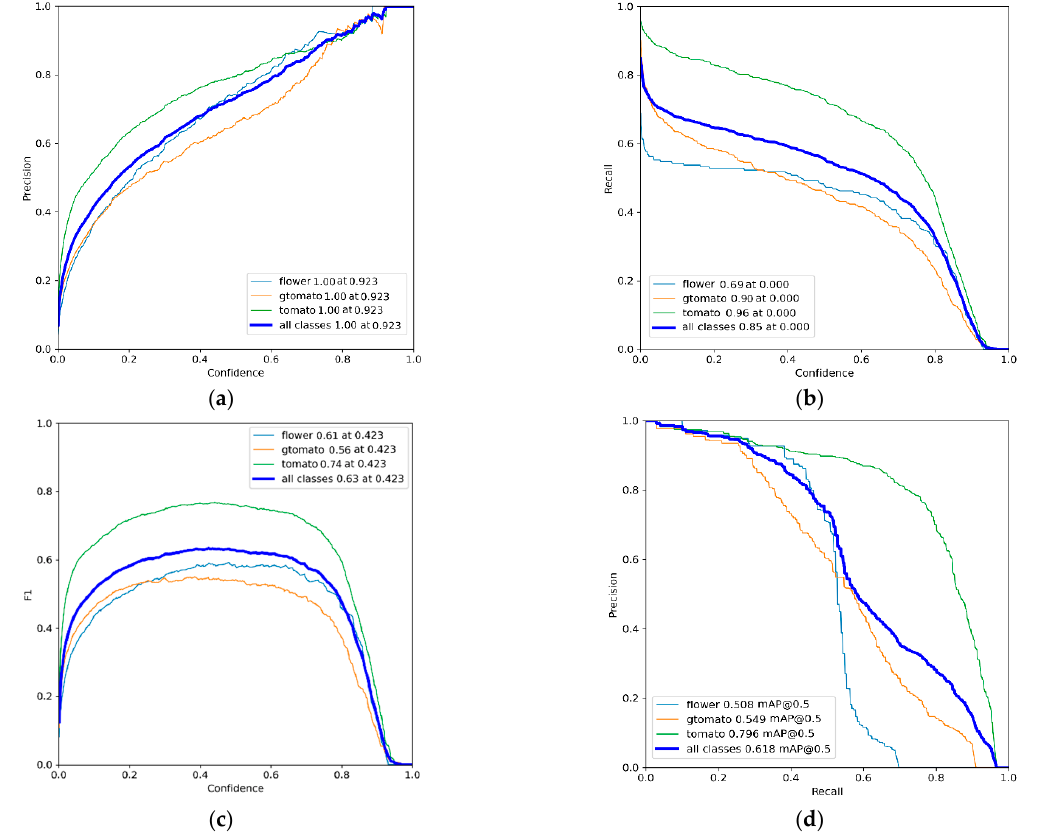
Figure 9. YOLO V5 performance parameters ( a ) P Curve ( b ) R Curve ( c ) F1 Curve ( d ) PR Curve.